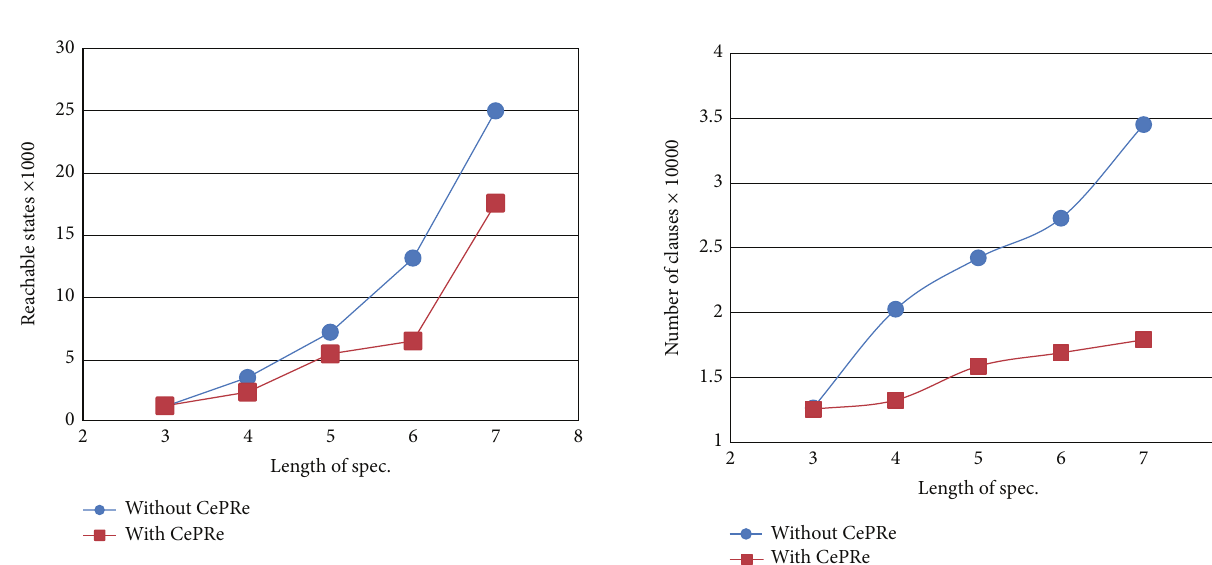
Figure 2: Results on reachable states in random BDD-MC experi- ments.